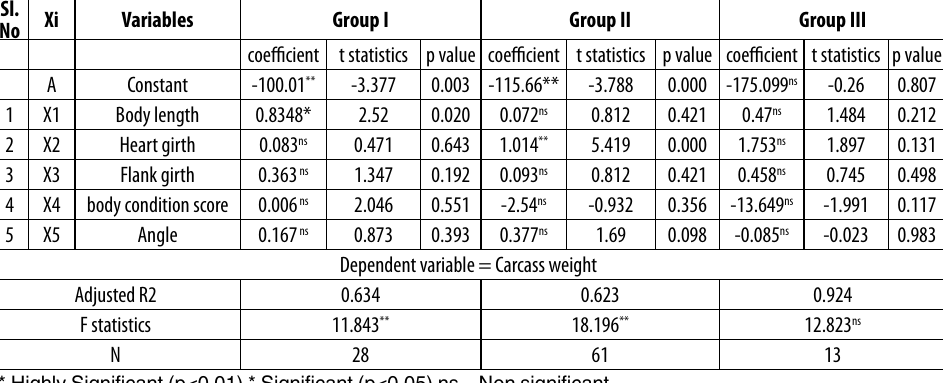
table 4. Regression analysis for developing prediction equation for carcass weight using live animal physical body measurements in three different weight groups Sl. Xi No